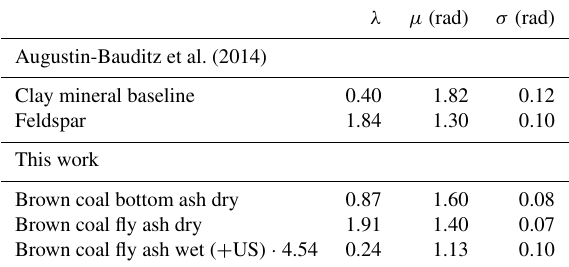
Table 4. Parameters for the model calculations based on the SBM. λ is the ice fraction in the saturation range, µ the mean contact angle, and σ the standard deviation of the contact angle distribution. The clay mineral baseline corresponds to different kinds of mineral dust which featured a similar immersion freezing behavior after coating with sulfuric